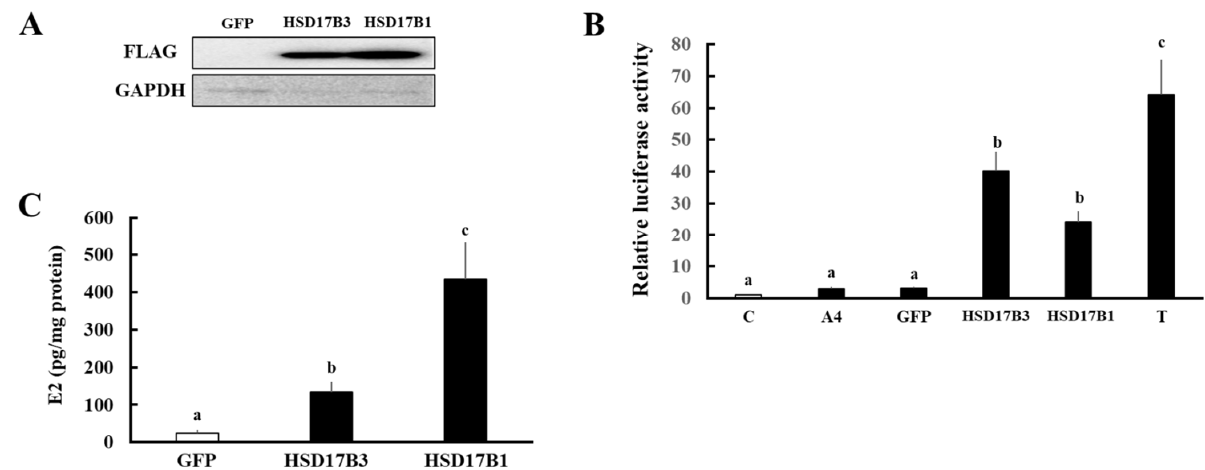
Figure 3. Evaluation of the enzymatic activities of ovine HSD17B3 and HSD17B1 using culture media from each gene-transfected HEK293 cells. ( A ) Western blot analyses were performed with the antibodies against FLLAG-tag and GAPDH using lysates of GFP-, FLAG-tagged ovine HSD17B3-, and FLAG-tagged ovine HSD17B1-introduced HEK293 cells. ( B ) Activation of ovine AR-mediated transcription by HSD17B3 and HSD17B1 using culture media from each gene-transfected HEK293 cell. CV-1 cells were transfected with ARE-Luc and ovine AR-expression vectors. At 24 h post-transfection, cells were incubated with vehicle (lane C), A4 (1 nM), T (1 nM), culture medium from GFP-, HSD17B3-, and HSD17B1-expressing HEK293 cells collected at 2 h after A4 addition for 24 h. Values of the vehicle were defined as 1. Data represent the mean ± SEM of four independent experiments. Values marked by the different letters are significantly different from each other ( p < 0.05). ( C ) Concentrations of E2 in culture medium from GFP-, HSD17B3-, and HSD17B1-introduced HEK293 cells at 3 h after addition of E1 (1 nM). Each column represents the mean ± SD of three independent experiments. Values marked by the different letters are significantly different with each other ( p < 0.05).